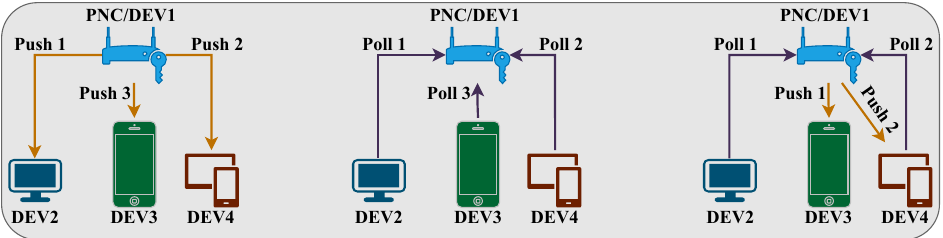
Figure 6. Architecture of FD-MAC